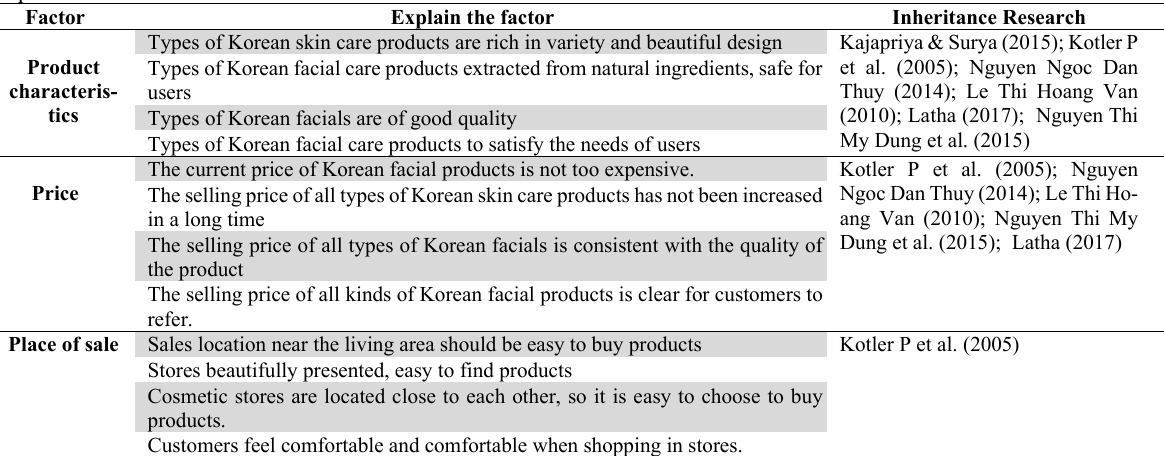
Fig. 1. Model of evaluating the factors affecting Korean students' decision to buy Korean facials products in Da Nang city Table 1 presents the structure of the questions associated with the proposed study of this paper. Table 1 Explain the variables of the